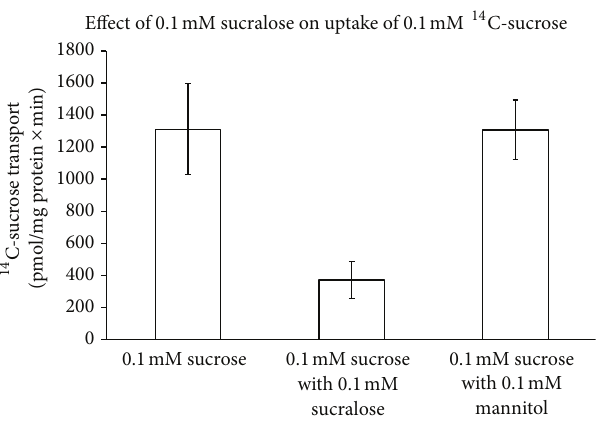
Figure 4: Transport inhibition data: pmol/(mg protein × min) for Streptomyces badius . This suggests that sucralose is an inhibitor of sucrose uptake via transport proteins in S. badius . The columns are means ± 1SEM ( 𝑛 = 5 ). Figure 5: An enzyme kinetics graph of the initial velocities of unin-